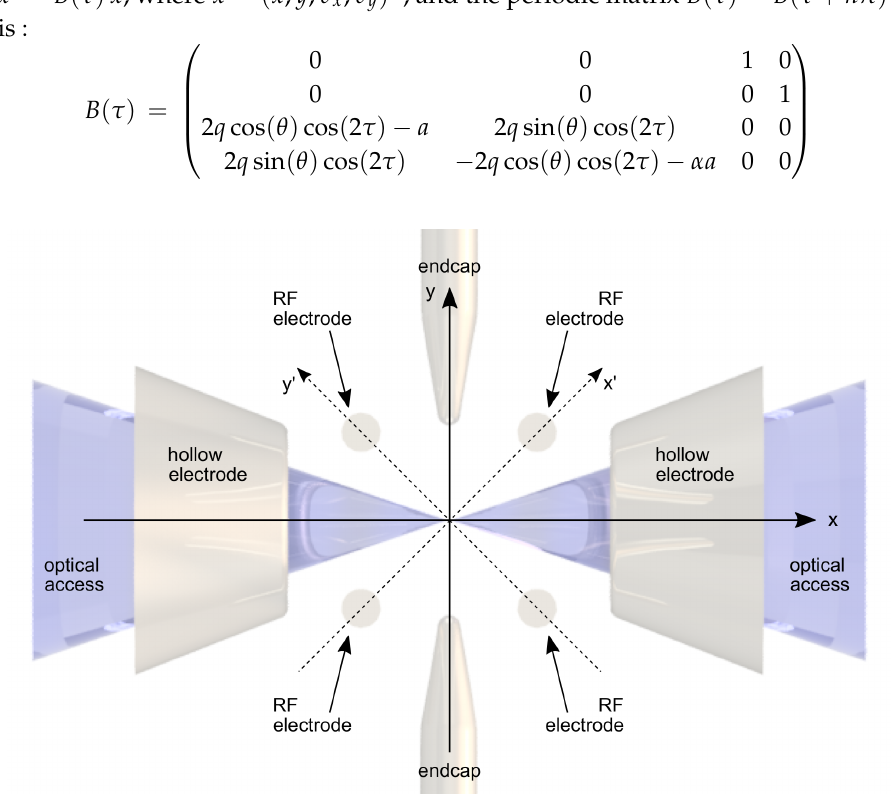
Figure 6. Conceptual sketch of the Paul trap electrodes’ position in relation to the electro-optical trap cone-shaped hollow electrodes. The RF electrodes are rotated 45 ◦ with respect to the endcaps’ frame, and the confinement along the z axis is provided by the negatively charged